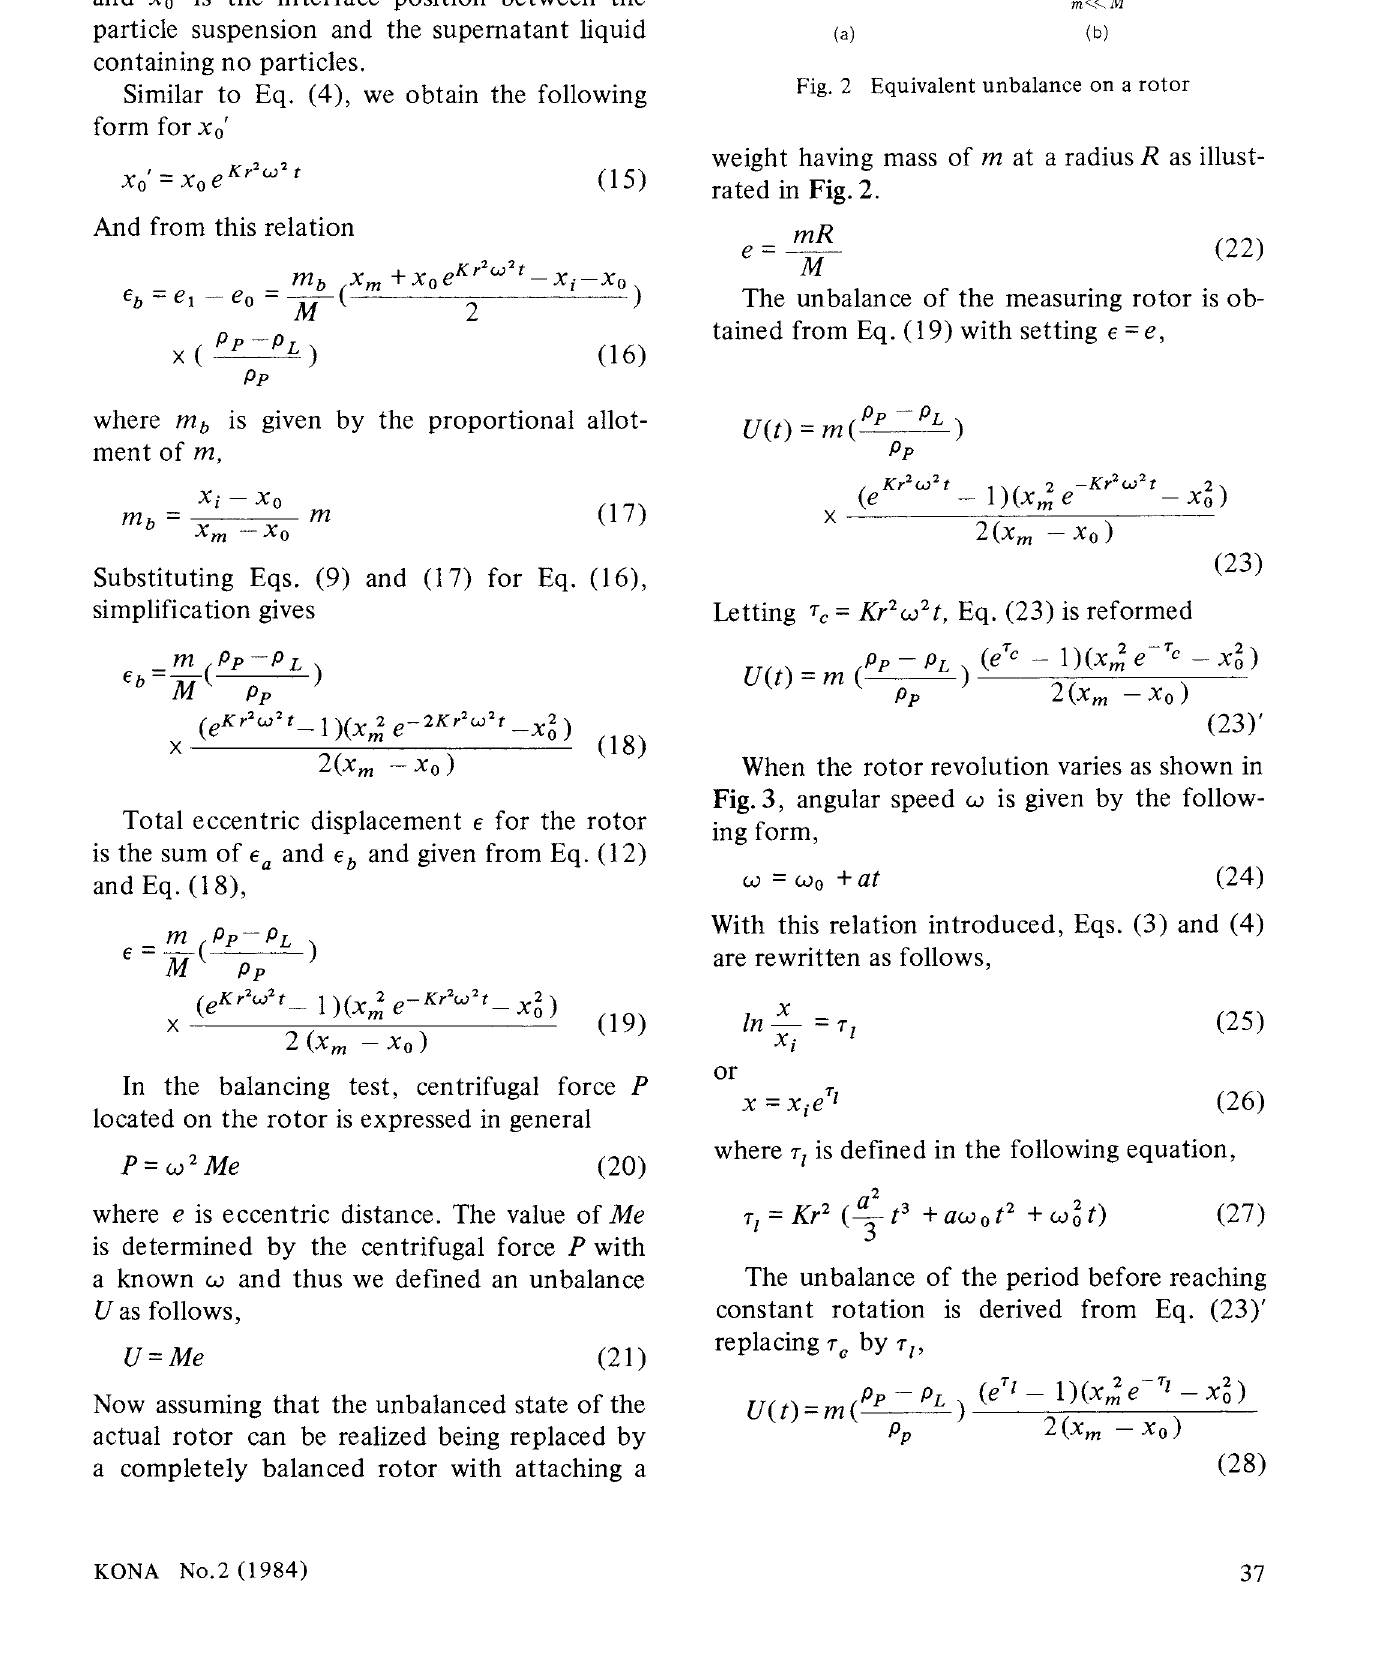
Fig. 2 Equivalent unbalance on a